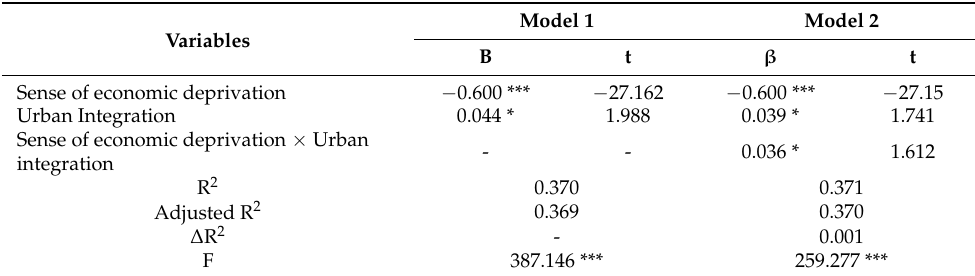
Table 9. The moderating effect of urban integration between perceived economic deprivation and social trust.